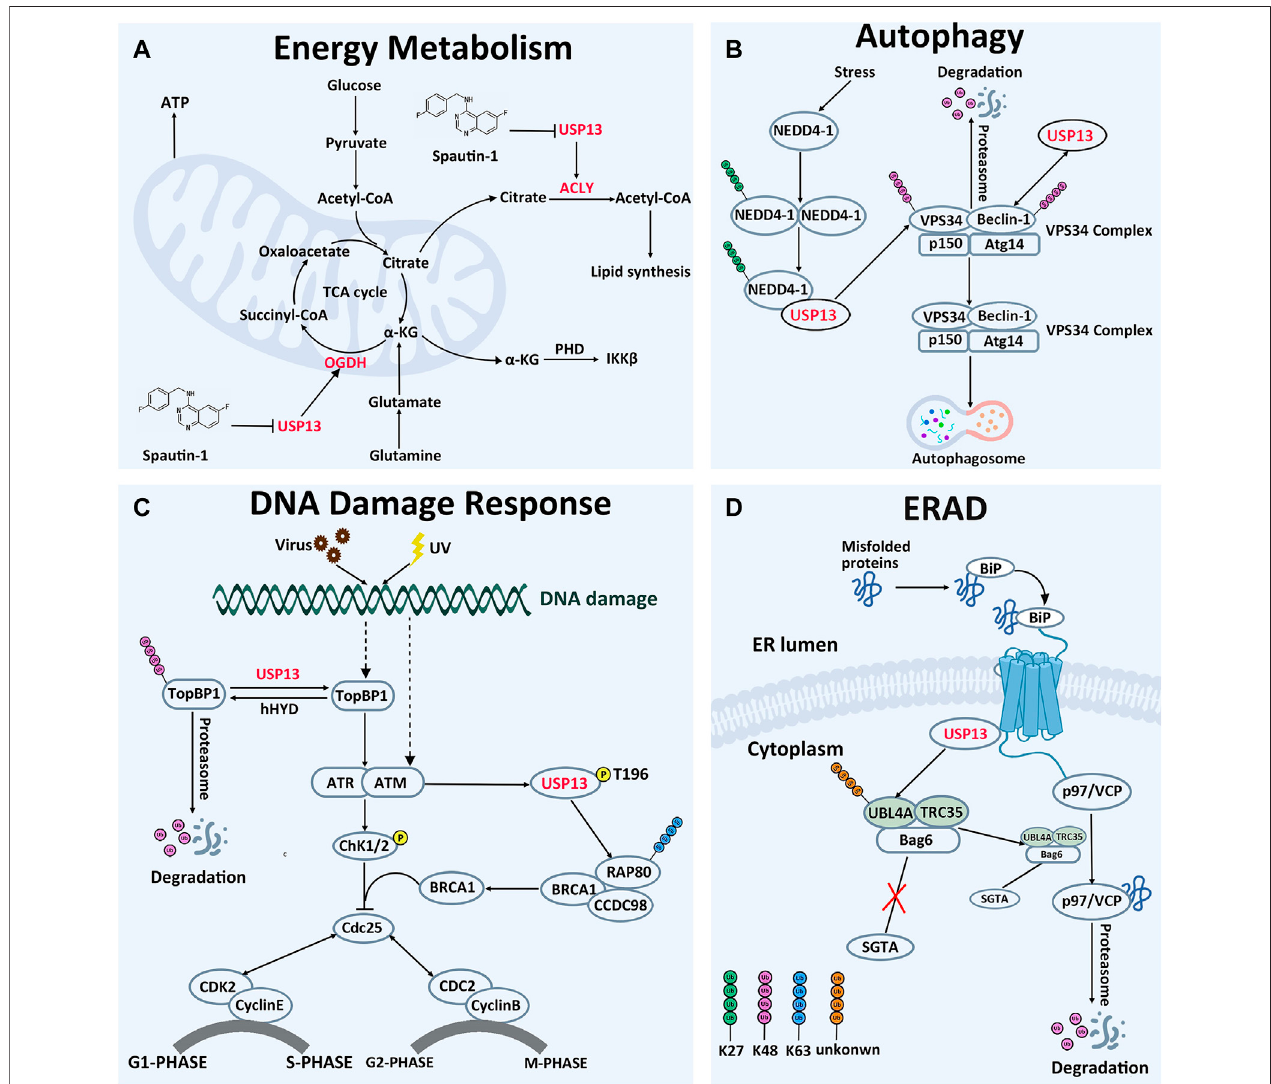
FIGURE3| CellularFunctionofUSP13. (A) Inenergymetabolism,USP13promotescellenergymetabolismbyremovingOGDHandACLYdegradationsignals. (B) Inautophagy,USP13isrecruitedbyauto-ubiquitinatedNEDD4-1toremoveVPS34subunitdegradationsignal.Ontheotherhand,USP13deubiquitinatedBeclin-1and removed the degradation signal of Beclin-1. Consequently, the VPS34 complex initiates autophagosome formation. K27-linked Ub chains are green, K48-linked Ub chains are pink. (C) In DNA damage reaction, USP13 antagonizes E3 ubiquitin ligase hHYD to remove the TopBP1 degradation signal, then TopBP1 activates the ATRsignalingpathwayandultimatelyactivatestheG1-Sphasecheckpoint,makingcellsremainintheG1phase.Inaddition,phosphorylatedUSP13byATMisrecruited toDNAdamage sitestocleavetheotherUbchainstofacilitateK63-linked ubiquitinchains,whichpromotesRAP80localizationandultimatelyactivatestheG2-Mphase checkpoint, making cells remain in the G2 phase. K48-linked Ub chains are pink. Phosphorylation is yellow. (D) In ERAD, hyper-ubiquitination of UBL4A can induce the cleavage and inactivation of Bag6, causing ERAD inhibition and inhibiting the interaction of UBL4A with SGTA directly. USP13 interacts physically with gp78 and Bag6, removing hyper-ubiquitination of UBL4A, controlling precisely the ERAD process. Unknown-linked Ub chains are orange.